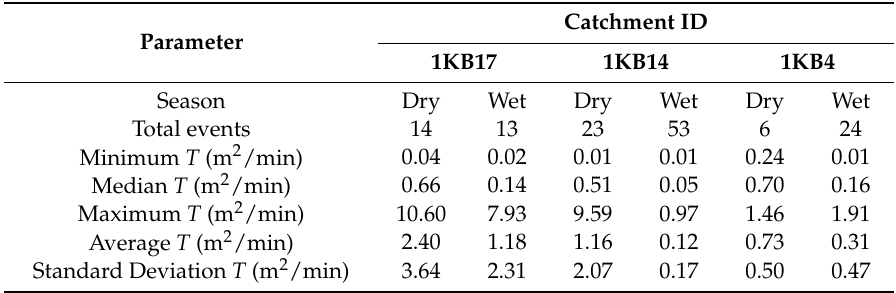
Table 5. Summary of seasonal streamflow-derived aquifer T values derived from streamflow across three catchments in Kilombero Valley. Number of total events depends on the number of recharge events occurring and the time base of a given